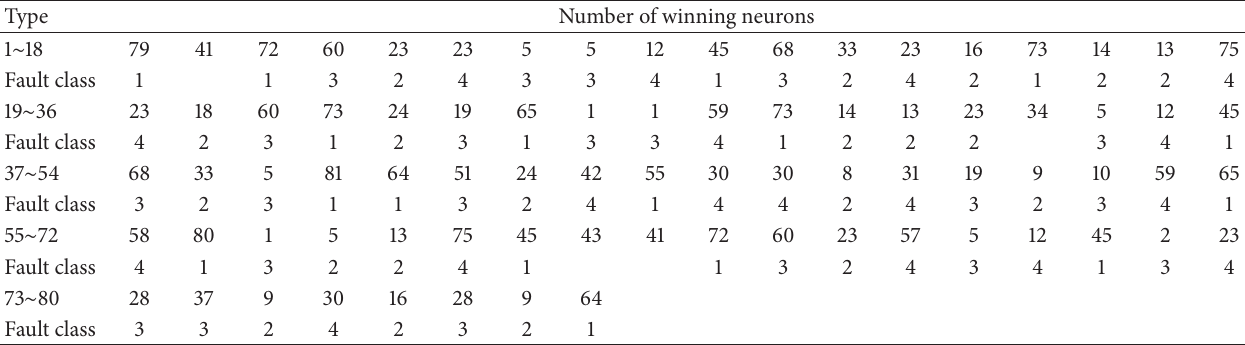
Table 8: Comparison between actual values and predicted values of SOM neural network optimized by improved PSO algorithm. Type Number of winning